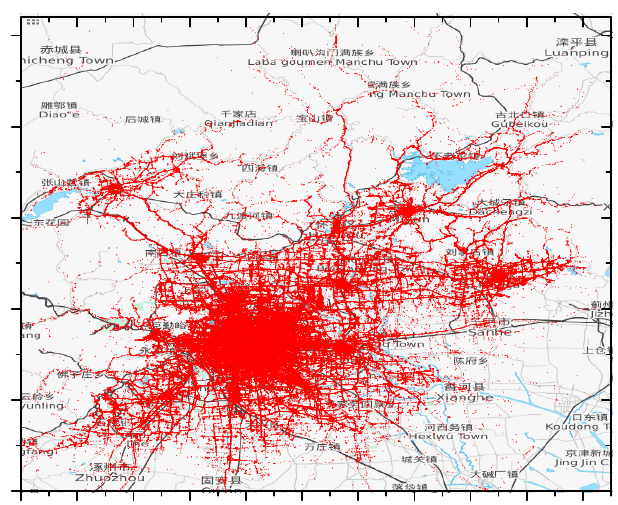
Figure 6. Visualization of the filtered T-Drive dataset (© OpenStreetMap Contributors).